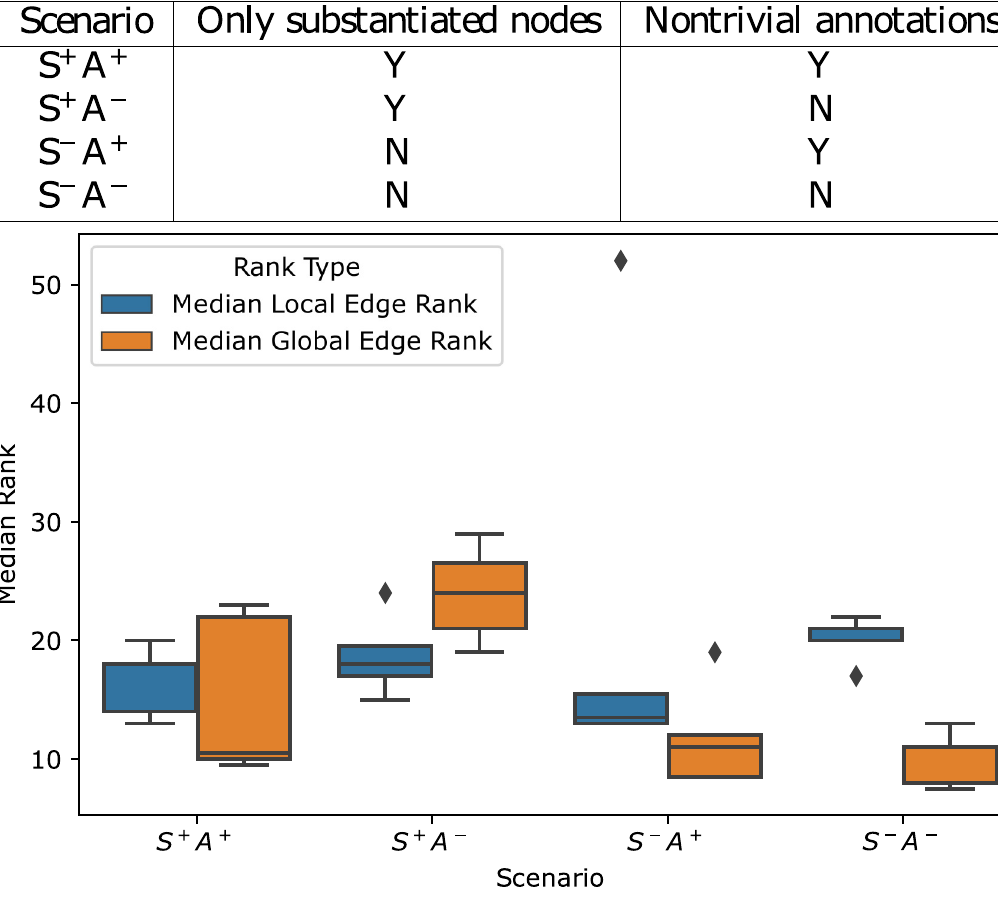
Fig 6. Summary of yeast cell cycle rank changes for substantiated edges in global edge ranking. The table shows the amount of information provided in each scenario. The box plots show the distributions of the median local (blue) and global (orange) edge rankings for the subset of substantiated edges with nonzero edge prevalence scores. A lower median indicates a better ranking and therefore a better result. In both S − scenarios, the global edge ranking outperforms the local edge ranking.